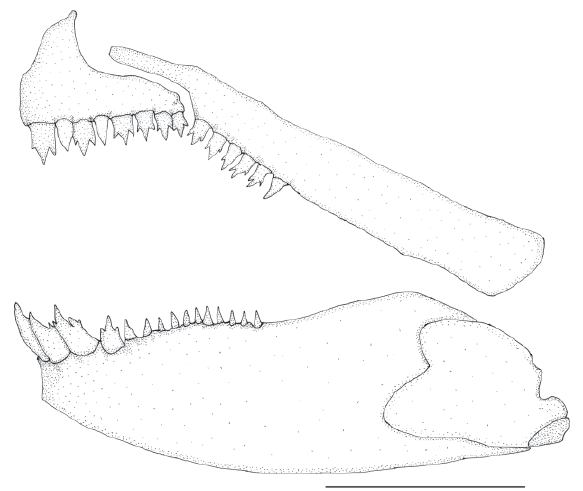
Fig. 11. Paratype of Hyphessobrycon weitzmanorum , MZUSP 73314. Upper and lower jaws, lateral view, left side. Scale